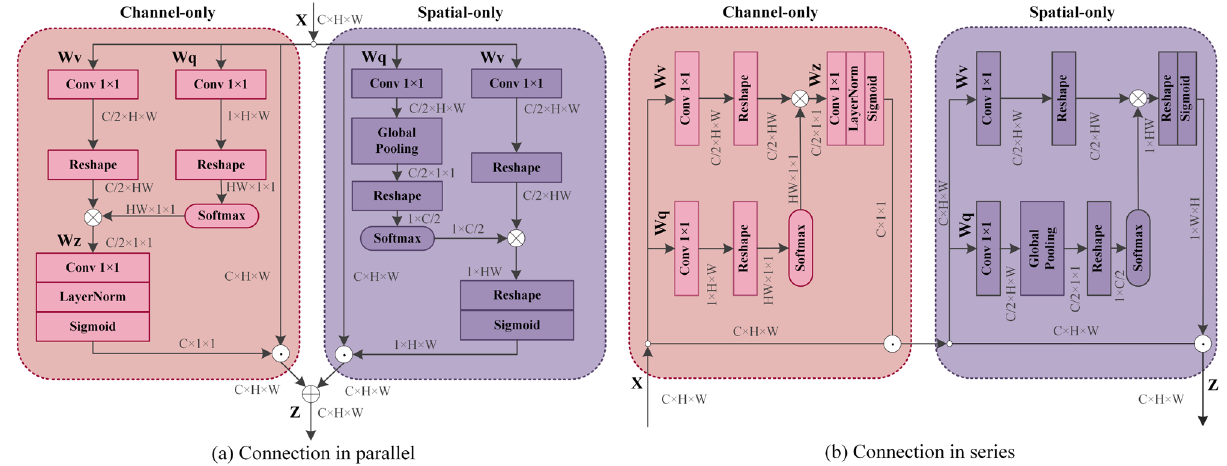
Figure 2. This is The PSA module ( a ) Connection in parallel and ( b ) Connection in